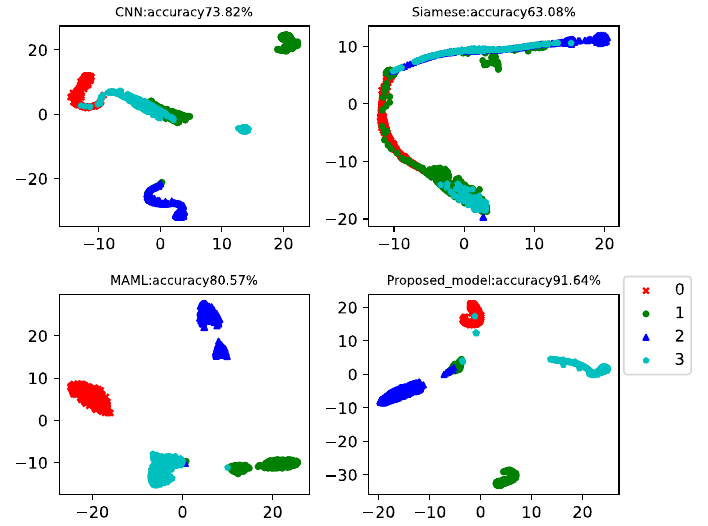
Figure 5. Four-way-one-shot diagnosis of the CWRU data for different algorithms.